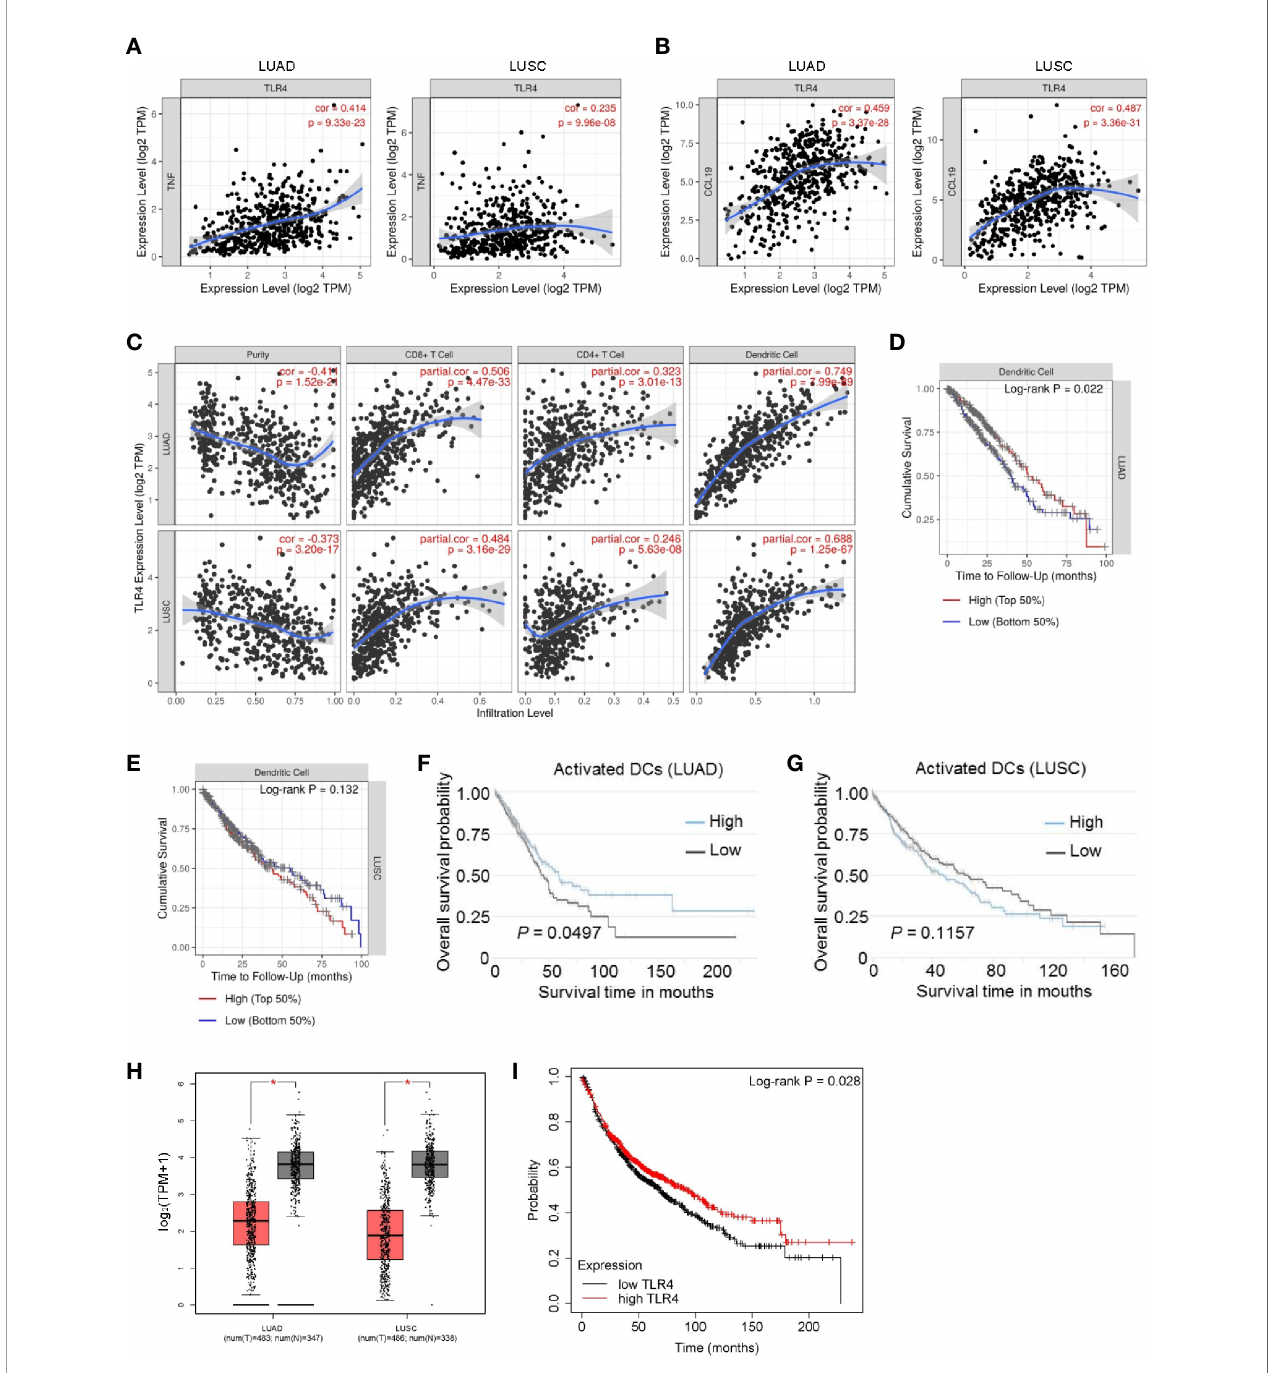
FIGURE 5 | The correlation and overall survival of tumor-in fi ltrating immune cells in NSCLC patients were analyzed using TIMER and TCIA. (A) The correlation of TLR4 and TNF a expressions was analyzed in LUAD and LUSC using TIMER; TPM, Transcripts Per Million. (B) The correlation of TLR4 and CCL19 expressions was analyzed in LUAD and LUSC using TIMER; TPM, Transcripts Per Million. (C) The correlation of TLR4 expression with immune cell in fi ltration levels was analyzed in LUAD and LUSC using TIMER. Tumor-in fi ltrating immune cells included CD8+ T cells, CD4+ T cells, and DCs. Gene expression levels against tumor purity are displayed in the left-most panel; TPM, Transcripts Per Million. (D, E) Overall survival rates of patients with high and low DC in fi ltration were analyzed in LUAD (D) and LUSC (E) using TIMER; LUAD, 501 patients, P =0.022; LUSC, 492 patients, P =0.132. (F, G) Overall survival rates of patients with high and low activated DC in fi ltration were analyzed in LUAD (F) and LUSC (G) using TCIA; LUAD, 506 patients, P =0.0497; LUSC, 495 patients, P =0.1157. (H) The expression of TLR4 in NSCLC (LUAD and LUSC) tissues and normal tissues was analyzed using GEPIA. (I) Overall survival rates of patients with high and low TLR4 expression were analyzed in lung cancer (n=1144 patients) using Kaplan-Meier Plotter; P